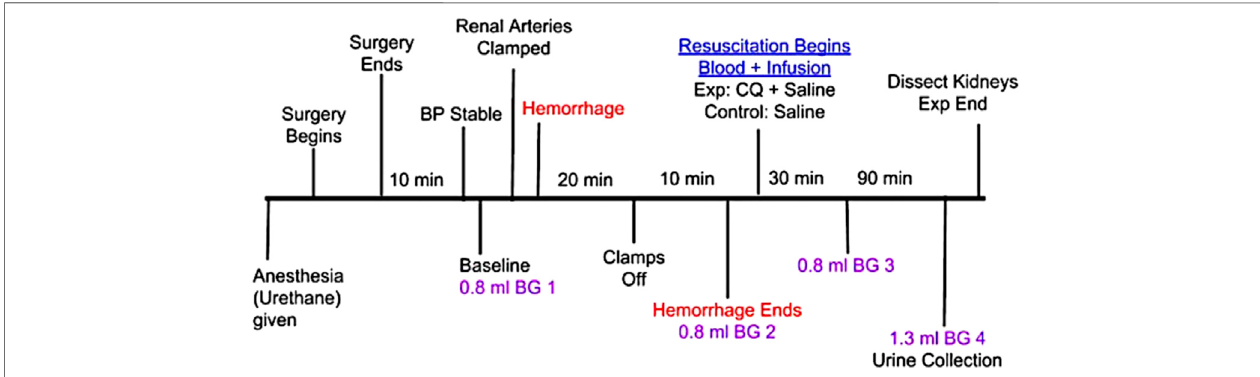
FIGURE 1 | Schematic representation of in vivo experiment in rats involving hypovolemic shock, acute kidney injury with kidney ischemia/reperfusion (I/R) and resuscitation with CQ. Procedure from anesthesia to the end of the in vivo experiment is shown with brief description of each step and time intervals of some important steps. B.G. – indicates a small volume blood collection for analyzing blood gas components.